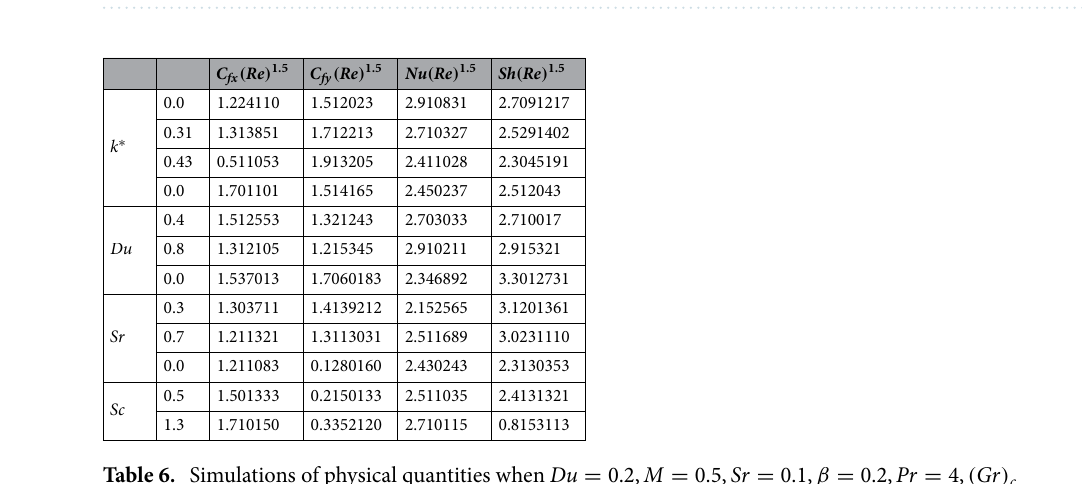
Figure 9. Influence of ( Gr ) t on θ when Du 0.5. M =